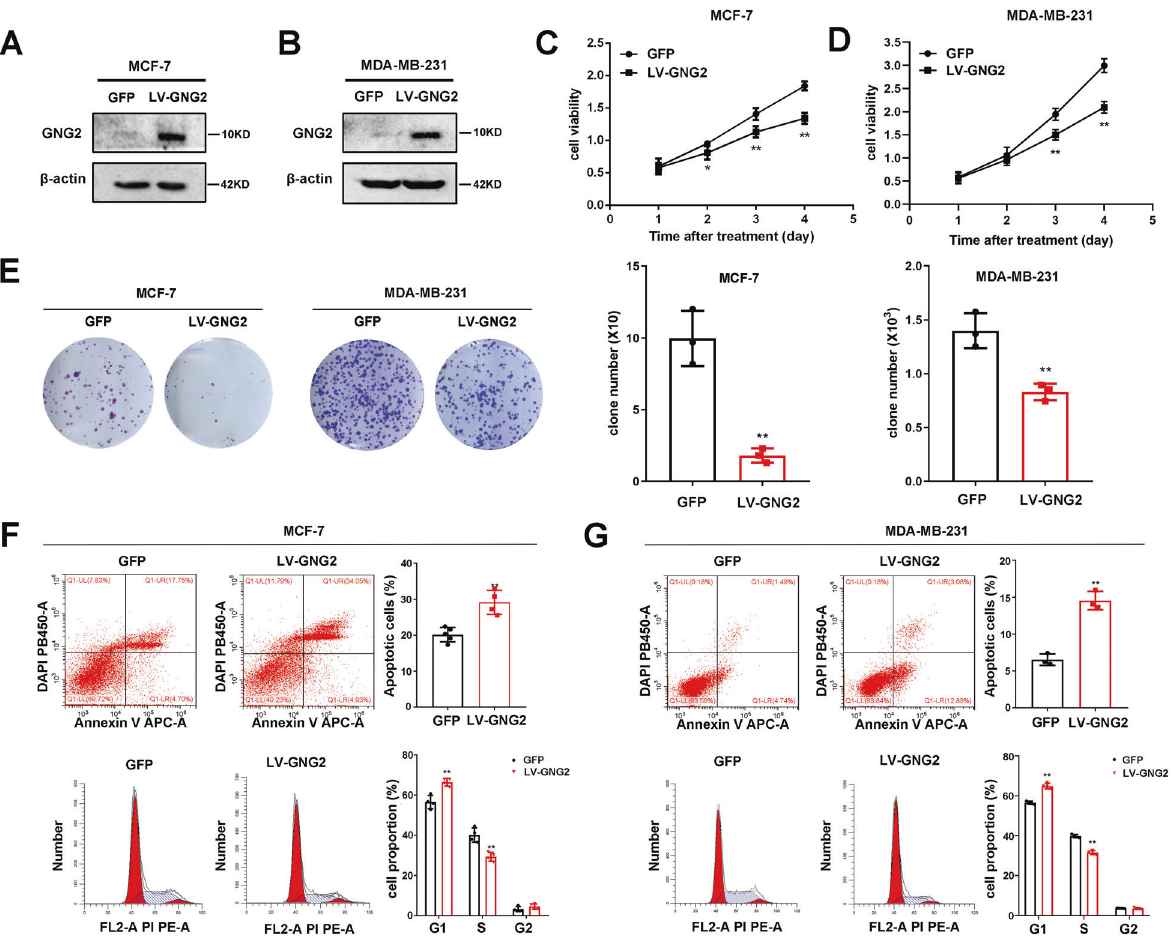
Fig. 4 GNG2 inhibits the proliferation of BC cells in vitro. MCF-7 and MDA-MB-231 cells transfected with LV-GFP or LV-GNG2 as described in the Methods. A and B GNG2 expression at protein levels in MCF-7 ( A ) and MDA-MB-231 ( B ) cells. C and D Effect of GNG2 overexpression on cell viability in MCF-7 ( C ) and MDA-MB-231 ( D ) cells was detected by CCK-8 assay. E Effect of GNG2 overexpression on cell proliferation was determined by colony formation assays ( n = 3). F and G Effect of GNG2 overexpression on cell apoptosis and cycle was measured in MCF-7 ( F ) and MDA-MB-231 ( G ) cells by fl ow cytometry analysis ( n = 4). Data are expressed as the mean ± SD. * p < 0.05, ** p < 0.01 vs.